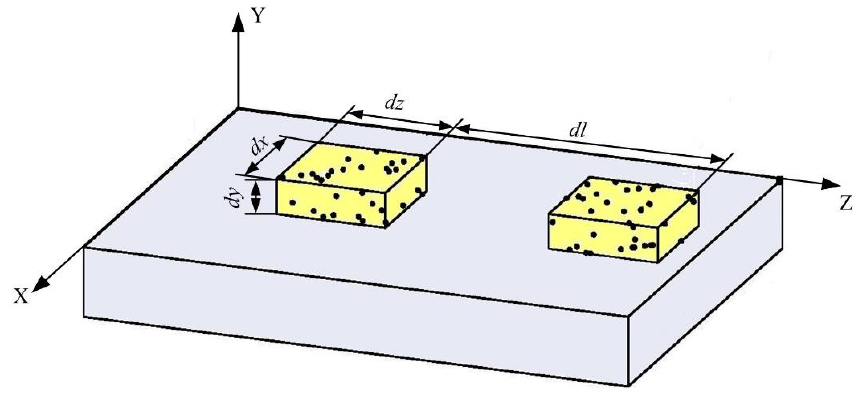
Figure 5. Diagram of material removal model of abrasive flow processing: 1, abrasive flow micro-body; 2, workpiece.